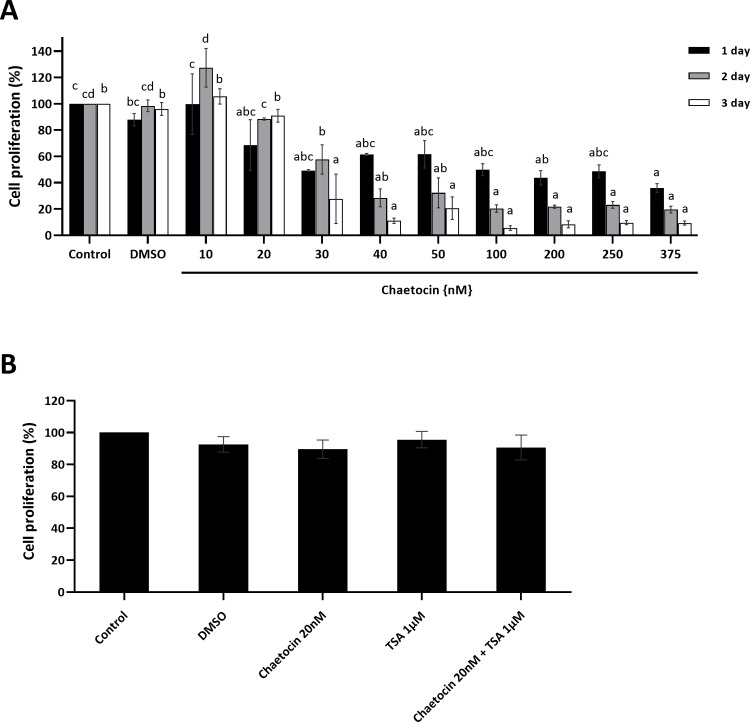
The effects of chaetocin on the proliferation of BFF cells.(A) Cell proliferation of BFF cells exposed to chaetocin–time course and dose-dependence study. BFF cells were exposed to chaetocin at the indicated concentrations for 1 (black bar), 2 (gray bar), and 3 days (white bar). (B) Cell proliferation of BFF cells exposed to chaetocin 20nM, trichostatin A (TSA) 1μM, and combination of chaetocin and TSA for 3 days. The MTS test was performed after indicated times of treatment. The results were normalized to control cells and are presented as the mean ± standard error of mean. DMSO (as a solvent) was used as a control. Different letters within one time point are significantly different at P< 0.05.